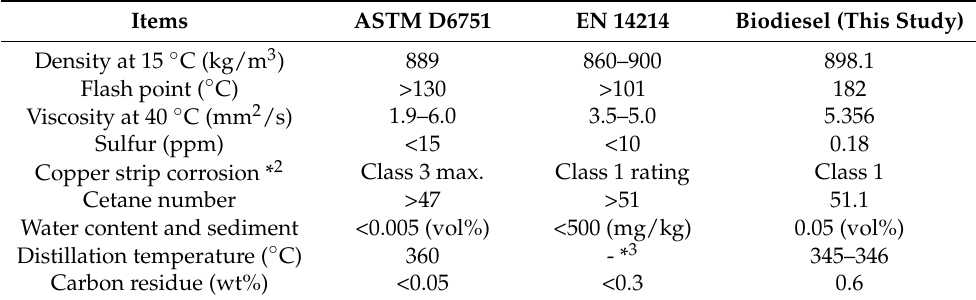
Table 2. Biodiesel specifications * 1 and the properties of the biodiesel made in this